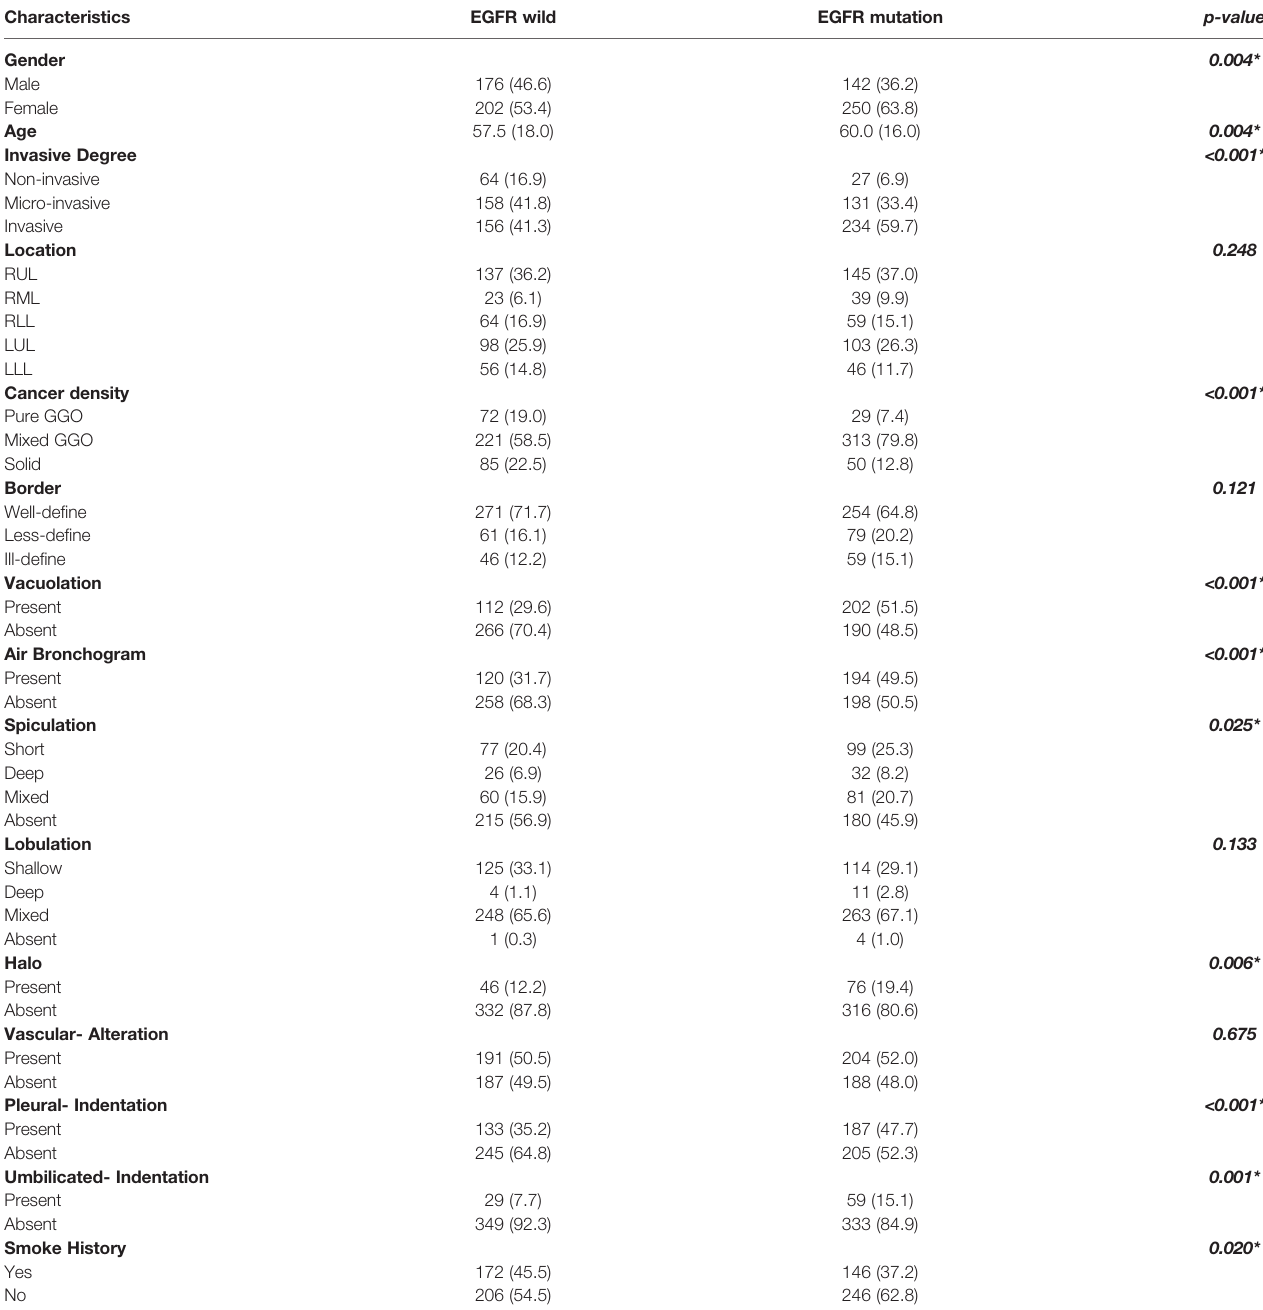
TABLE 1 | The distribution of clinical-radiology features for EGFR mutant and wild type cases in the training set.